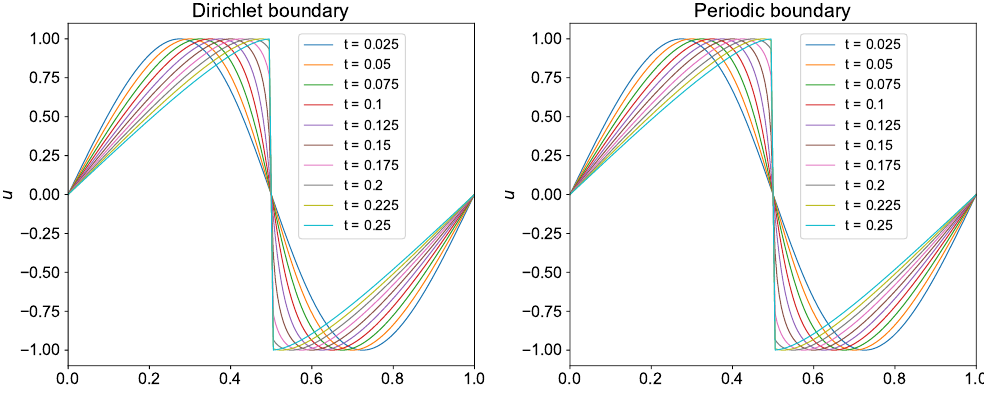
Figure 8. Evolution of shock with time for the initial condition u 0 = sin ( 2 π x ) using WENO-5